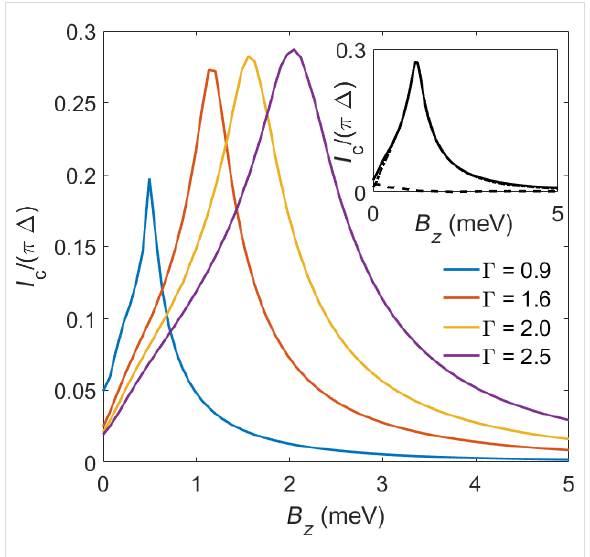
Figure 9: Main panel: Mean-field results for I c vs B z in S–QD–TS junc- tions for several values of Γ S = Γ TS = Γ (in meV) and μ = 4 meV. The bulk Zeeman field V x = 5 meV along (where V x > for our param- eters) is applied to the spinful TS wire, while the QD is subject to the local magnetic field B = B z . All other parameters are as in Figure 8. Inset: Decomposition of I c into ABS (dotted-dashed) and continuum (dashed) contributions for Γ = 1.6